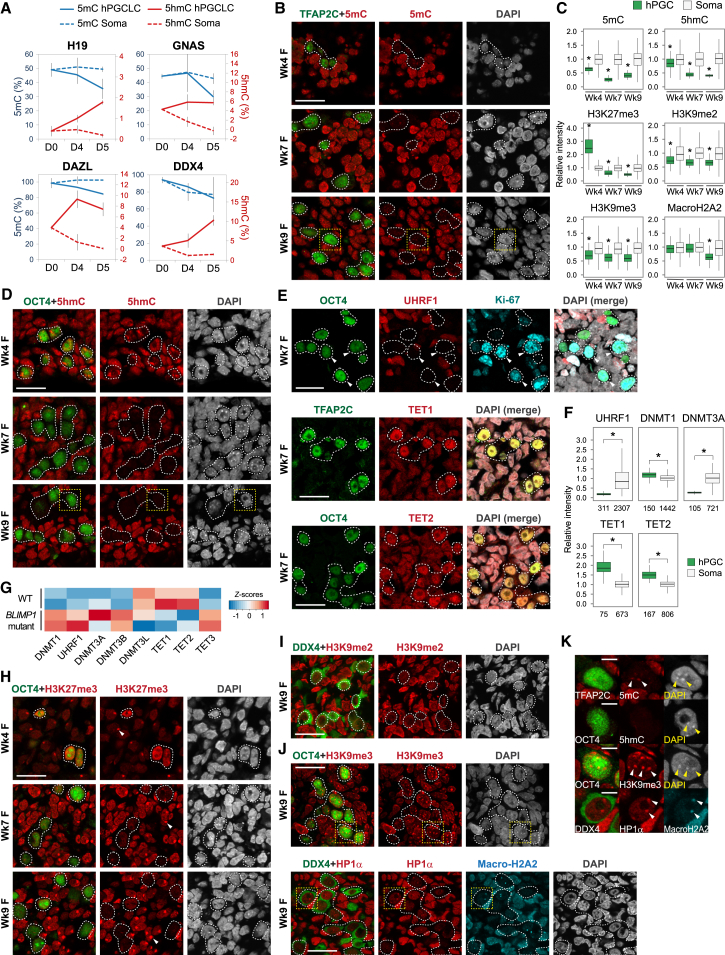
DNA Demethylation and Chromatin Reorganization in the Human Germline(A) 5mC and 5hmC levels at ICRs of H19 and GNAS ICRs and promoters of DAZL and DDX4 in hPGCLCs and surrounding soma determined by Glu-qPCR. Day (D) 0 represents 4i ESCs. Data are represented as mean ± SEM of two biological replicates.(B and D) Immunofluorescence analysis for (B) 5-methylcytosine (5mC) and (D) 5-hydroxymethylcytosine (5hmC) on human embryo cryosections. hPGCs are counterstained by TFAP2C or OCT4. Scale bars, 20 μm.(C) Fluorescence intensity of indicated epigenetic modifications in hPGCs and surrounding soma (corresponds to images in Figures 3B, 3D, 3H–3J, S3E, and S3F). Around 20–800 hPGCs and >200 soma are used for quantification at each time point. (∗p < 0.01 between hPGC and soma; Wilcoxon signed-rank test.)(E) Immunofluorescence analysis for UHRF1, TET1, and TET2 on genital ridge. Arrowheads indicate Ki-67-positive (proliferating) hPGCs, which are UHRF1 negative. Scale bars, 20 μm.(F) Fluorescence intensity of epigenetic modifiers in Wk7 female hPGCs and surrounding soma (corresponds to images in Figures 3E, S3A, and S3B). Sample sizes are indicated. (∗p < 0.0001; Wilcoxon signed-rank test.)(G) Expression of epigenetic modifiers in biological replicates of day 4 wild-type (WT) and BLIMP1 mutant hPGCLCs by RNA-seq.(H–J) Immunofluorescence analysis for (H) H3K27me3, (I) H3K9me2, (J) H3K9me3, and HP1α/ MacroH2A2. Arrowheads in (H) indicate H3K27me3 foci in somatic cells. Scale bars, 20 μm.(K) Magnified immunofluorescence images (corresponds to yellow boxes in Figures 3B, 3D, and 3J) showing hPGCs with enrichment of 5mC, H3K9me3, and MacroH2A2 at chromocenters (arrowheads), which is not the case for 5hmC. Scale bars, 5 μm.See also Figure S3.